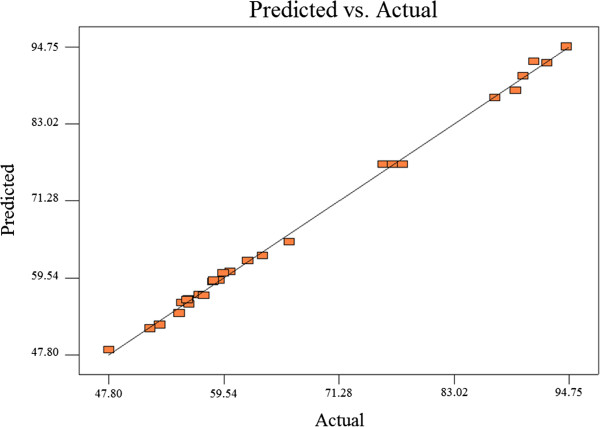
Plot of the actual and predicted values for %MTBE removal.